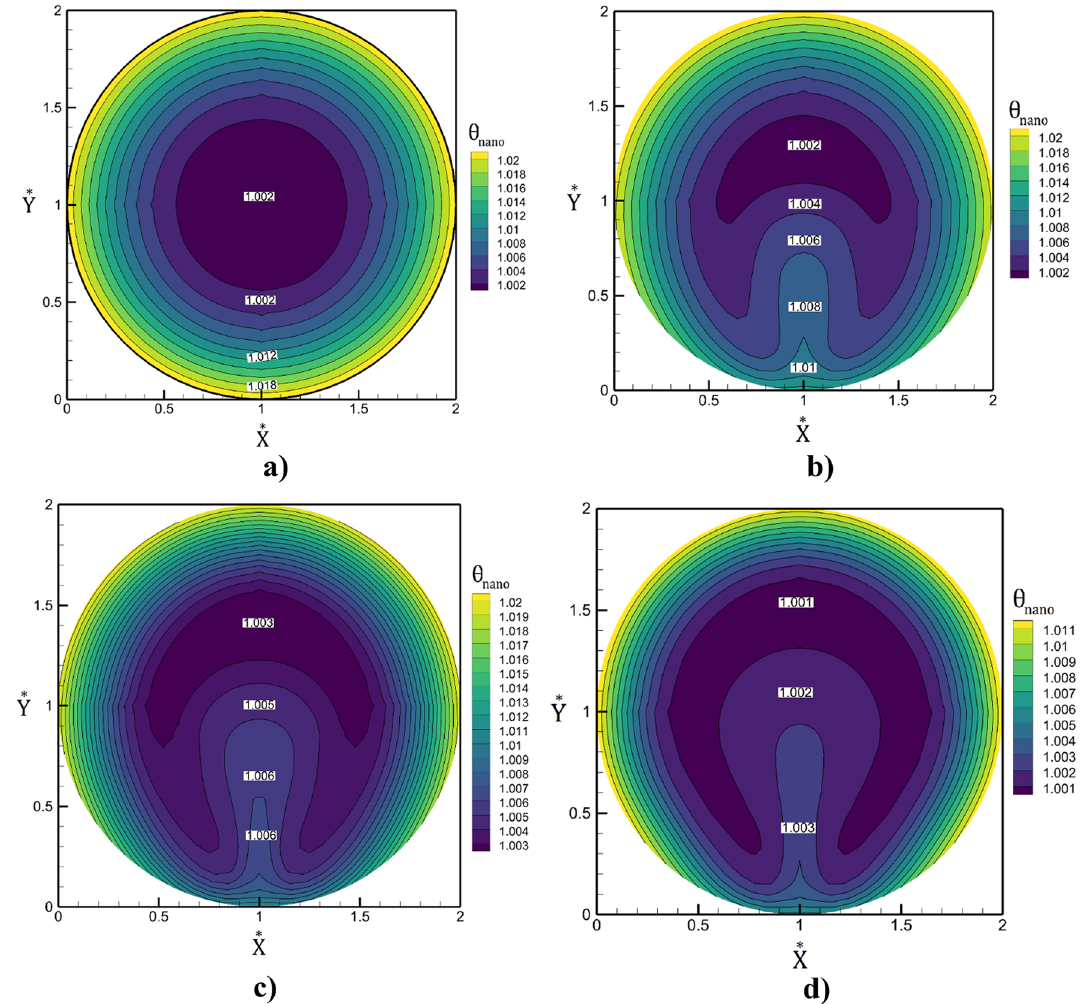
Figure 8. Contour of non-dimensional temperature in the mid-section of tube ( a ) Mn = 0, ( b ) Mn = 1.088 × 10 6 , ( c ) Mn = 2.22 × 10 6 , ( d ) Mn = 3.47 × 10 6